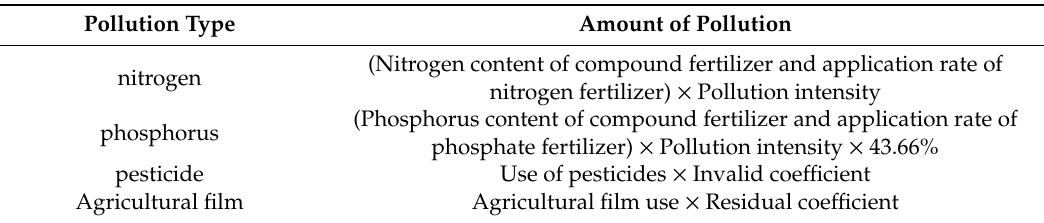
Table 3. The type of pollution and amount of agricultural non-point